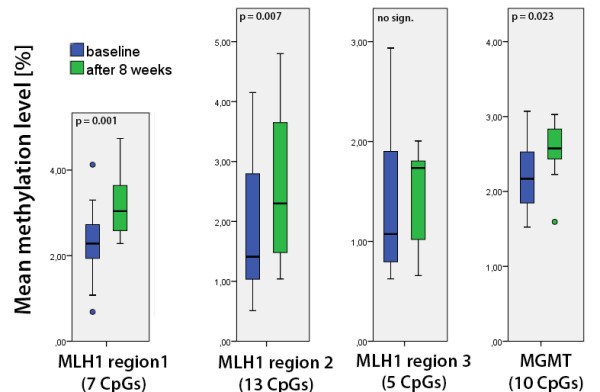
Mean DNA methylation levels. Mean DNA methylation levels in the intervention groups. Non-insulin-dependent diabetes mellitus type 2 (NIDDM2) and impaired fasting glucose (IFG) groups were pooled as they showed almost the same picture and no group-specific DNA methylation differences between baseline and T1 were found. P-values are based on the paired t-test.